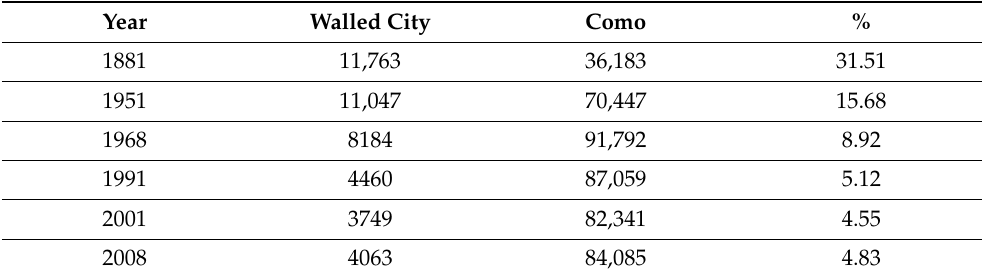
Table 1. The population of the Walled City of Como compared to the whole population of the Como Municipality between 1881 and 2008. (Municipality of Como, Piano di Governo del Territorio).